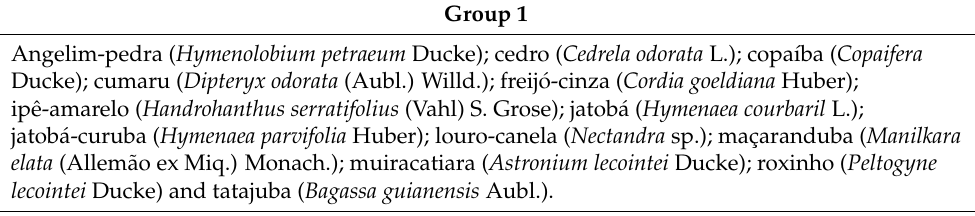
Table 1. Species (popular and scientific name) classified by market value group, forest management area of Fazenda Shet (535.6 ha), Dom Eliseu, State of Par á , Brazil. Group